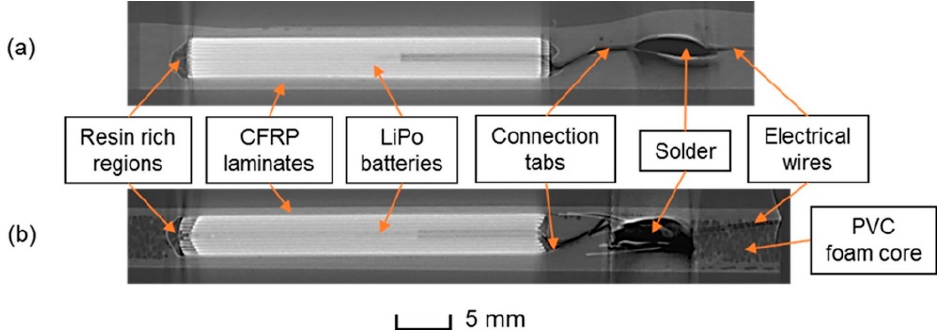
Figure 3. Examples of integrated conventional storage: cross ‐ sectional X ‐ ray CT images of an embedded LiPo pouch cell in ( a ) CFRP laminate and ( b ) sandwich composite [38].